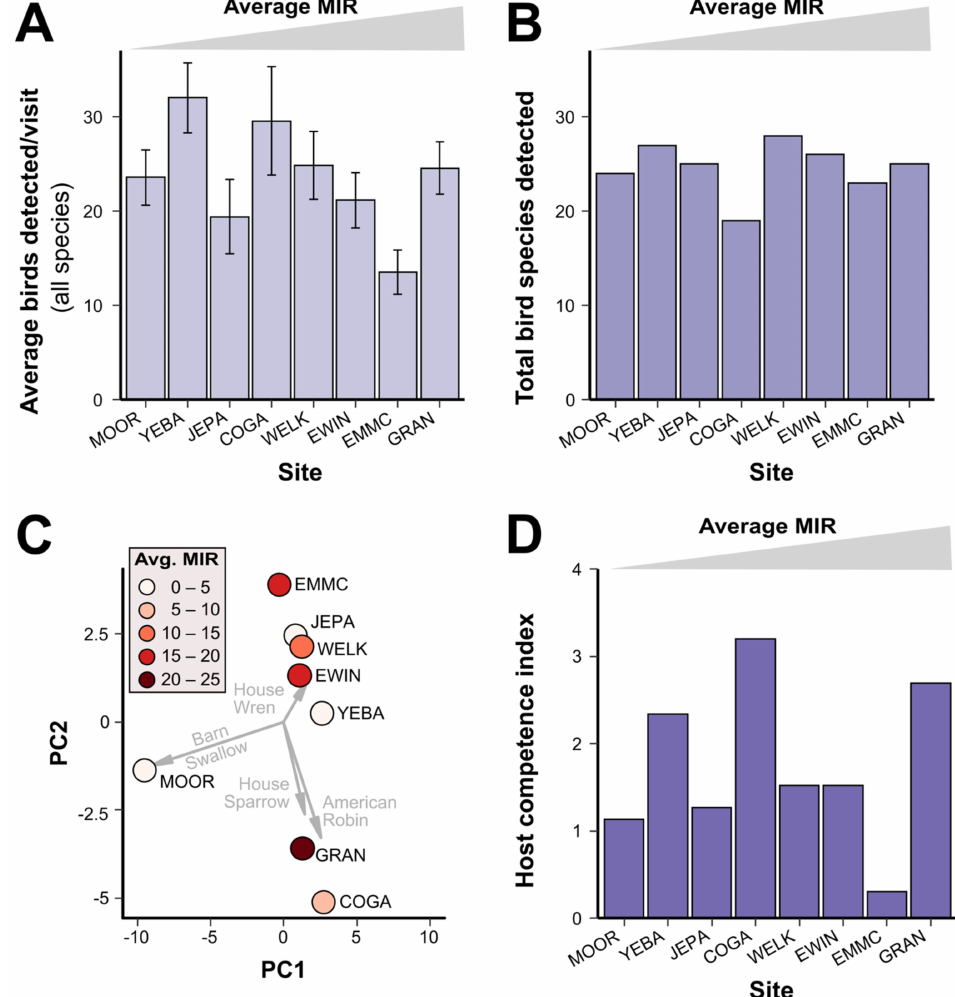
Figure 3. Avian communities are not indicative of mosquito WNV activity across sites. Descriptive plots of representative avian community metrics across study sites: abundance ( A ), richness ( B ), community composition visualized through principal component analysis ( C ), and host competence index ( D ). While all species were included in the analyses displayed in ( A , B , D ), only the four most common species from each site were used to generate the analyses depicted in ( C ). Common names of bird species most influential in the principal component analysis are displayed in